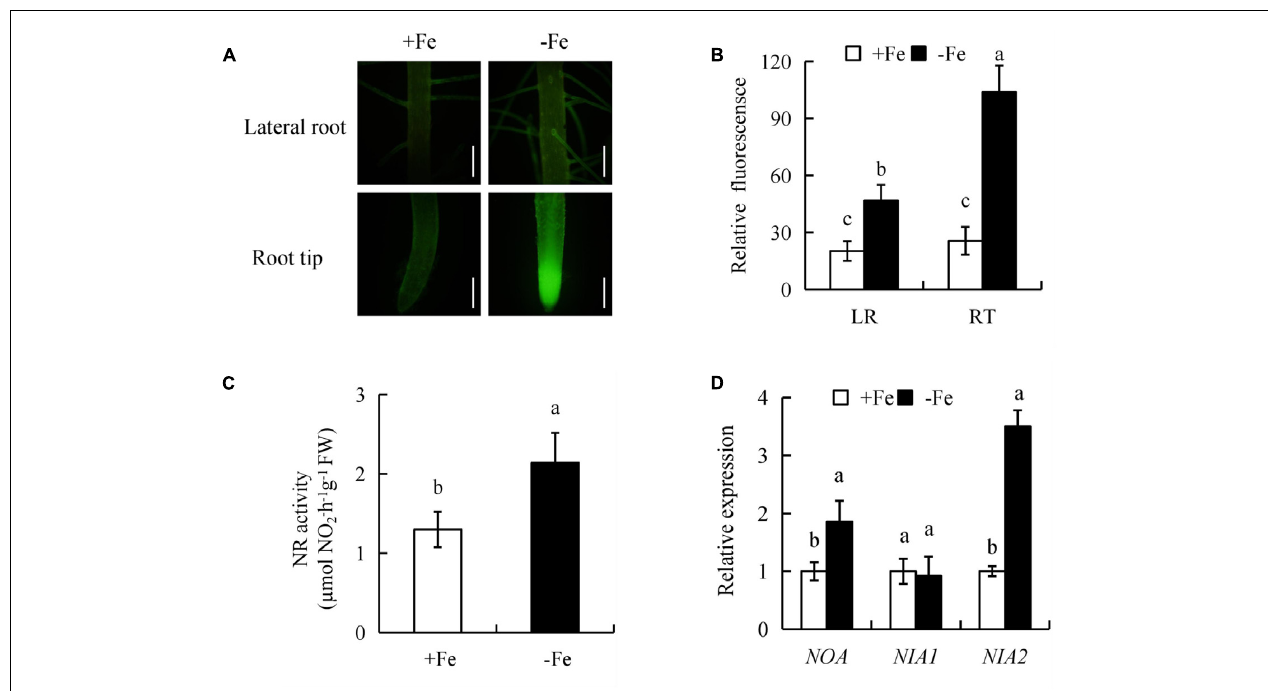
FIGURE 6 | Accumulation of nitric oxide (NO), relative nitrate reductase (NR) activity, and qRT-PCR analysis of NO-associated ( NOA ), NIA1 , NIA2 genes in the rice seedlings. Seedlings were grown in hydroponic medium containing − Fe (0 µ M) and +Fe (20 µ M) for 14 days. (A,B) Photographs of NO production shown as green fluorescence in the seminal roots (A) , and NO production expressed as fluorescence intensity relative to the roots (B) . (C) Relative nitrate reductase (NR) activity in the roots. (D) Relative expression of NOA , NIA1 , and NIA2 in roots. Bar=1 mm. Data are means ± SE and bars with different letters indicate significant difference at P < 0.05 tested with